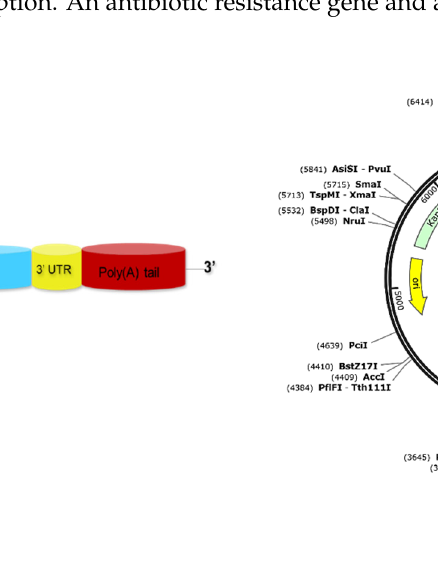
Figure 13. ( a ) Illustration of the complete in vitro transcribed mRNA construct with a cap, un-translated regions (UTRs), Kozak sequence, signal peptide sequence, and linked to the coding area, a poly (A) tail; ( b ) plasmid pET28a(+) containing the definitive vaccine construct (NS1–mRNA).